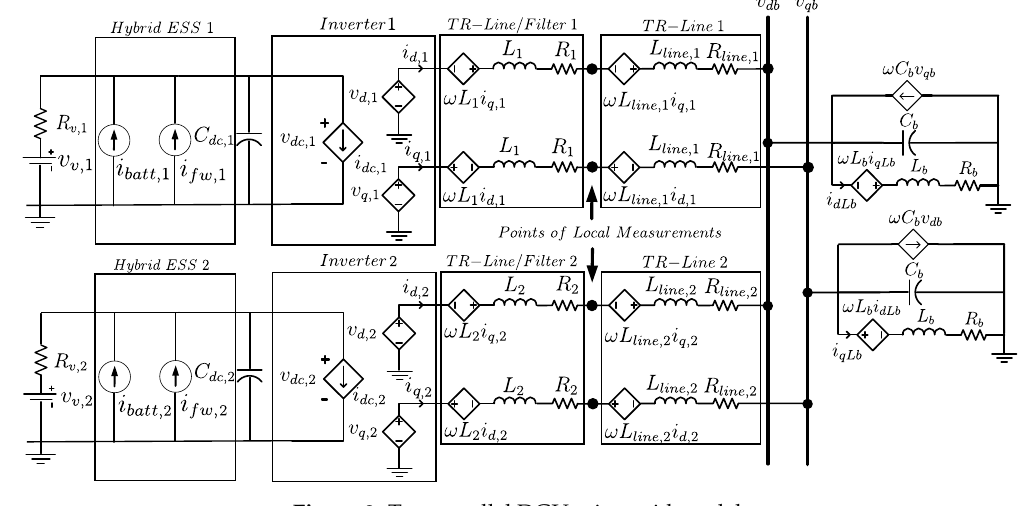
Figure 2. Two parallel DGU microgrid